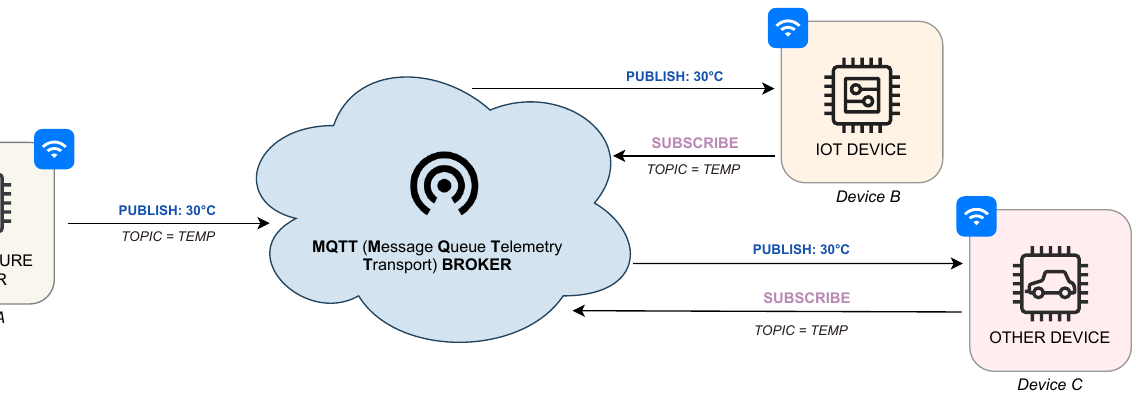
Figure 2. IoT communication